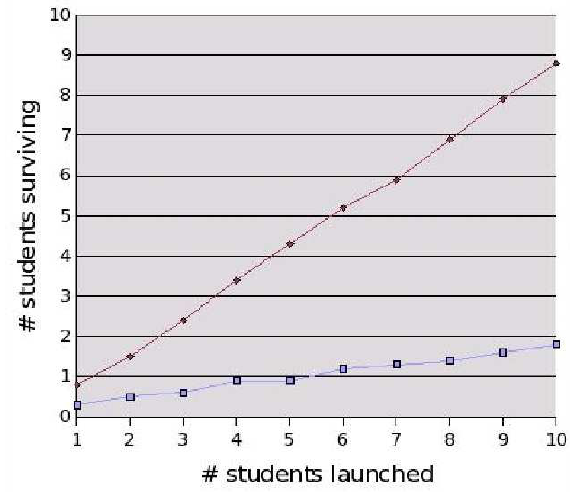
Figure 8. Survival rate of a population of agents with (red curve with diamonds) and without (blue curve with squares) imitation capability. The x axis represents the number of agents launched in the environment, the y axisthenumberofsurvivingagents(theonesthatsuccededinfinding all needed